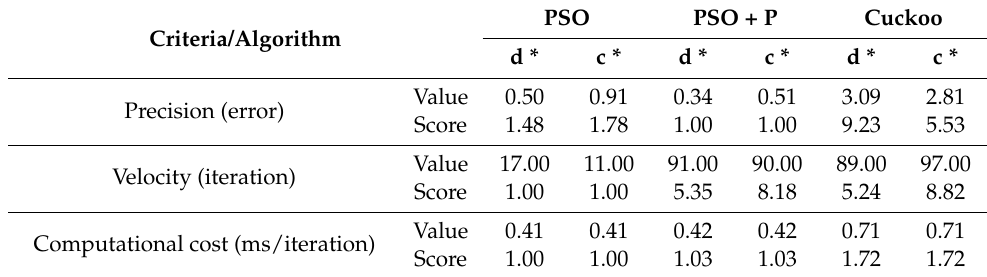
Table 3. Algorithm comparison using the minimal mean error reached. d * = discharge mode; c * = charge mode. PSO PSO + P Criteria/Algorithm